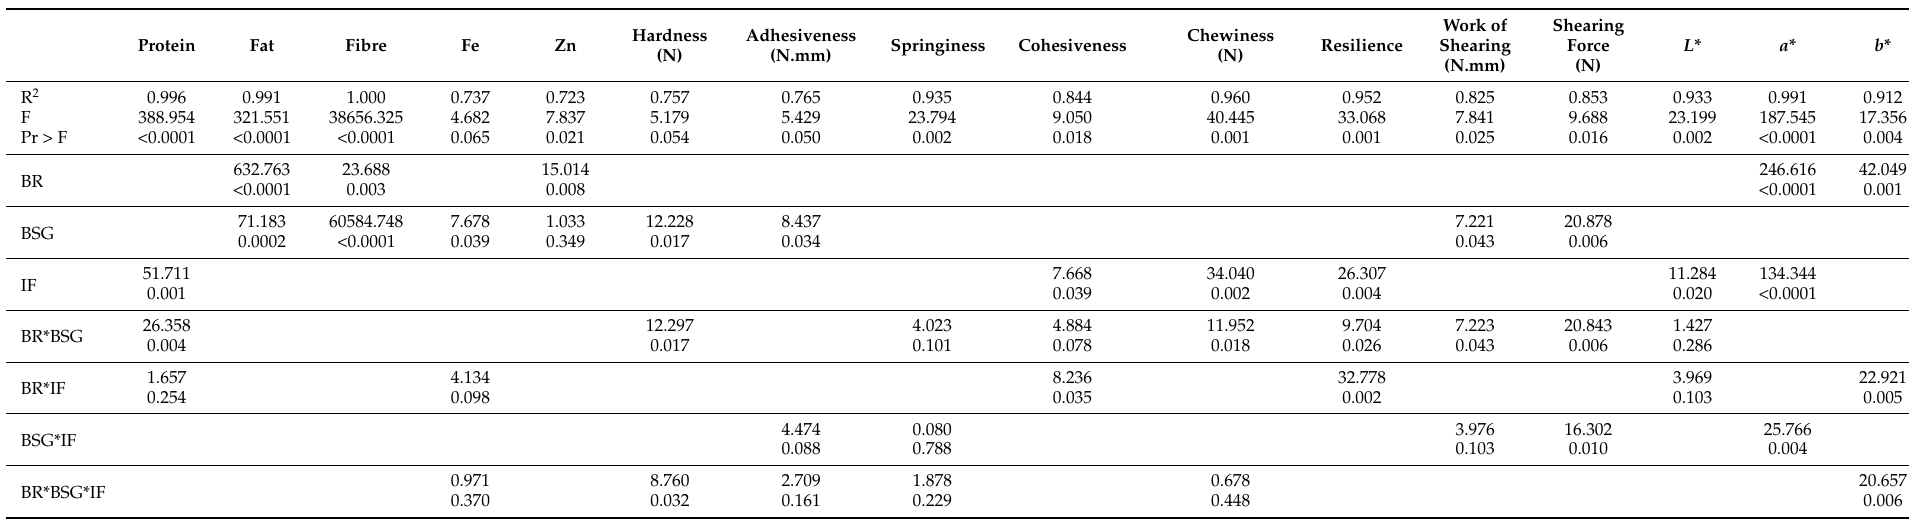
Table 4. Summary of statistics for the multiple linear regression, showing R-squared fit, F-value, and p -value for the model and for each independent variable and their